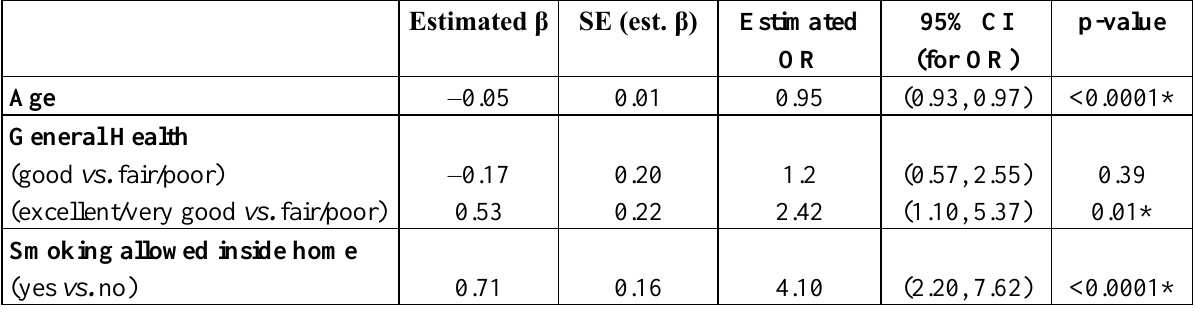
Table 3. Logistic Regression Showing Predictors of being Current versus Former Smoker (n =